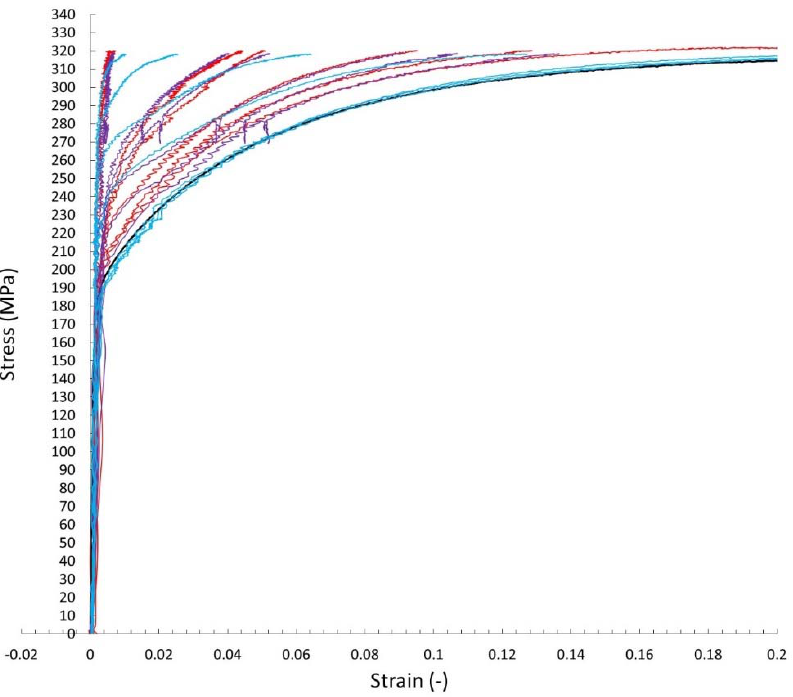
Figure 11. The curves of the static tensile test determined on the basis of the DIC method for welded joints made in manual welding processes: red - MAG 135; purple - MAG 138; blue – manual laser welding with additional material; black - base material.